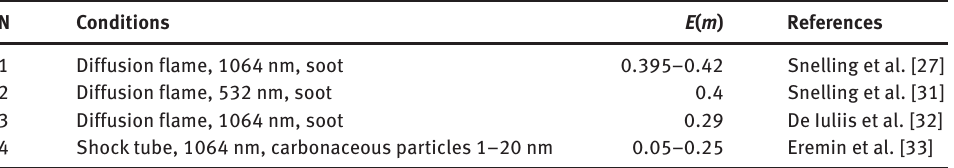
Table 1: The refractive index function values of soot particles measured by pulsed laser heating. N Conditions E ( m ) Diffusion flame, 1064 nm,